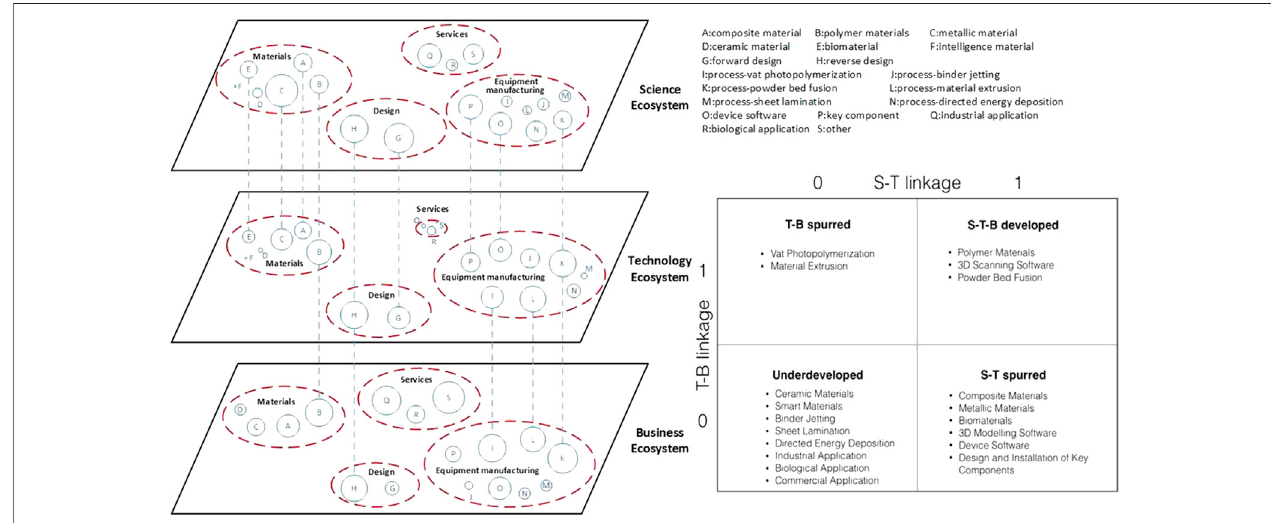
FIGURE 3 | Example of cross-layer analysis and visualization of a collaborative network in a science – technology – business ecosystem. Source: Xu et al. (2017).